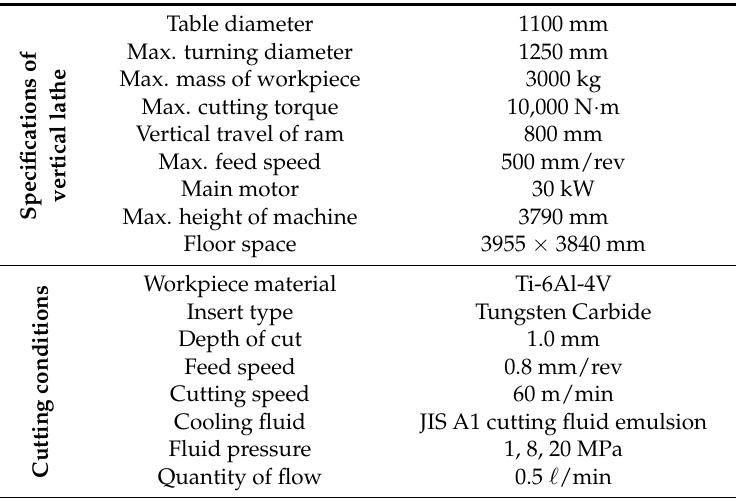
Figure 2. Vertical lathe used for experimentation. Table 1. Specification of vertical lathe and cutting conditions used in the experiment.